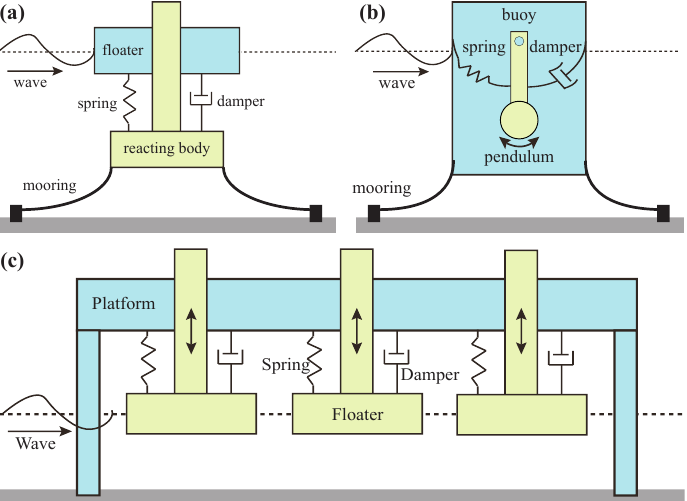
Figure 6. The self-reacting, self-contained and multi-point PAs are illustrated in ( a – c ), respectively.